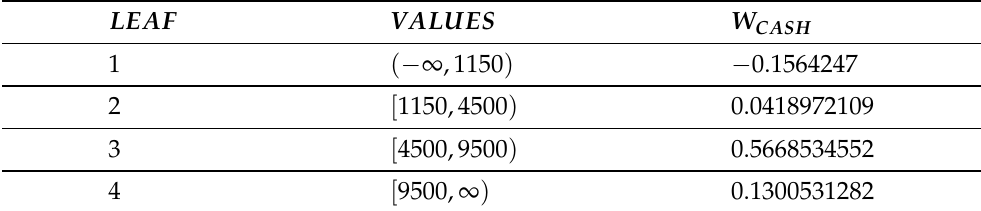
Table 6. Values obtained for W CASH from the tree depicted in Figure 6